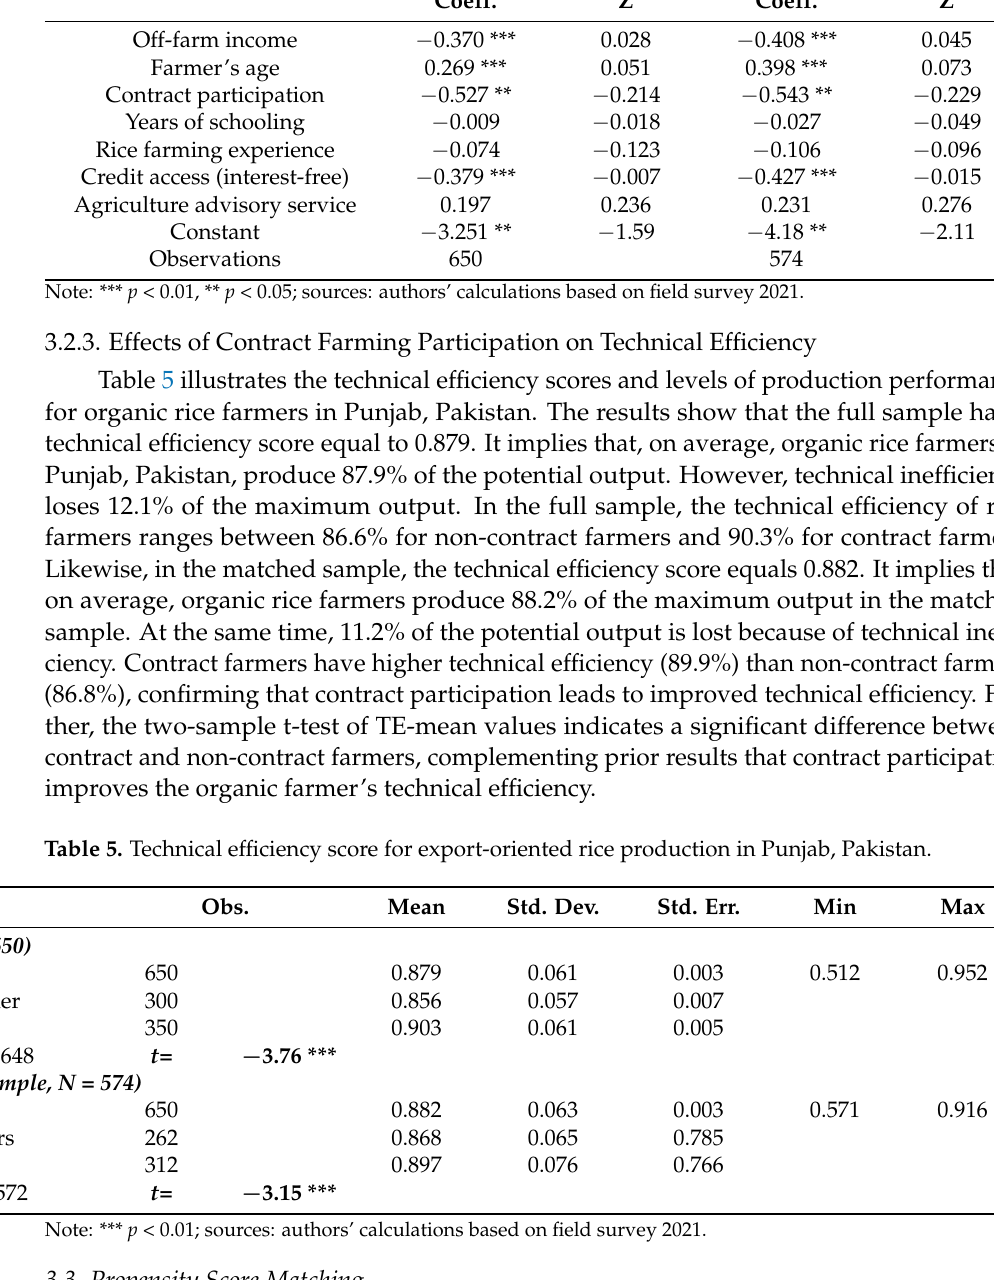
Contract participation